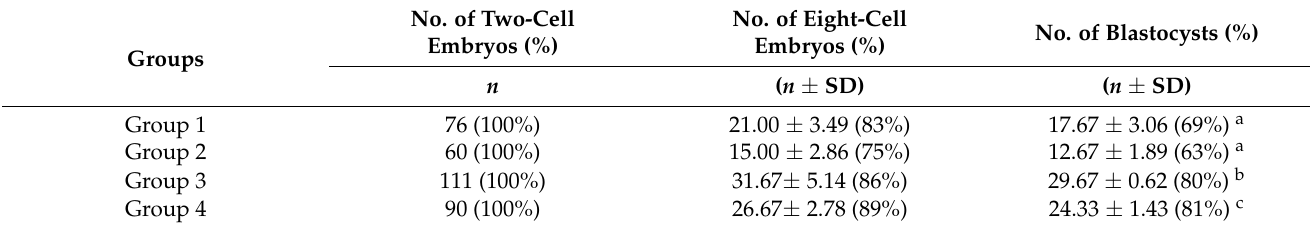
Figure 2. Morphologies of two-cell in vitro cultures to eight-cell embryos that underwent vitrification and without vitrification were observed until development to blastocyst stage from Groups 1–4. Arrows show fragmented embryos. Group 1 (GSH-free medium); Group 2 (GSH-free medium with vitrification); Group 3 (0.01 mM GSH-supplemented medium), Group 4 (0.01 mM GSH-sup- plemented medium with vitrification). The scale bar for the images represents 25 μ m. Table 2. Effect of GSH supplementation on the development of